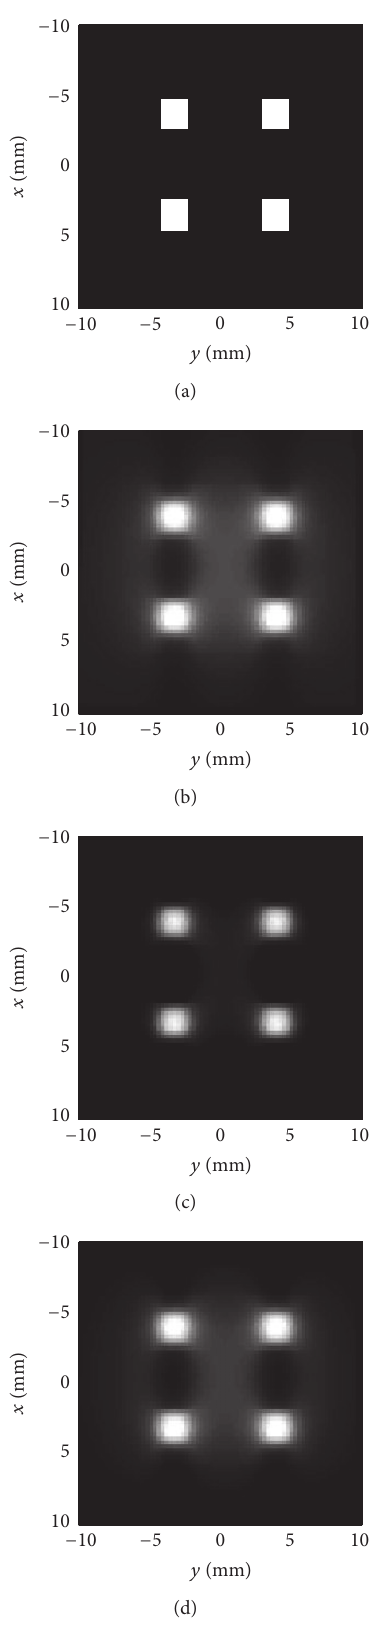
Figure 9: 2D image recovery: (a) imaging phantoms, (b) ideal 𝑥 - space image, (c) filtered image, and (d) recovered